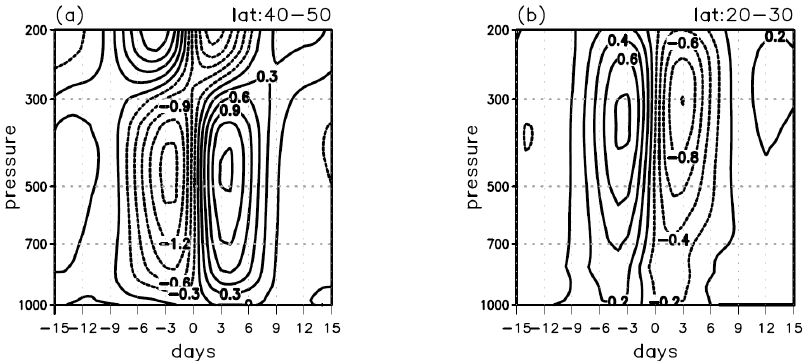
Figure 6. The time-altitude profile of the 10–40-day filtered temperature tendency in the north ( a ), and south ( b ) of the exit region. Unit: °C/d.